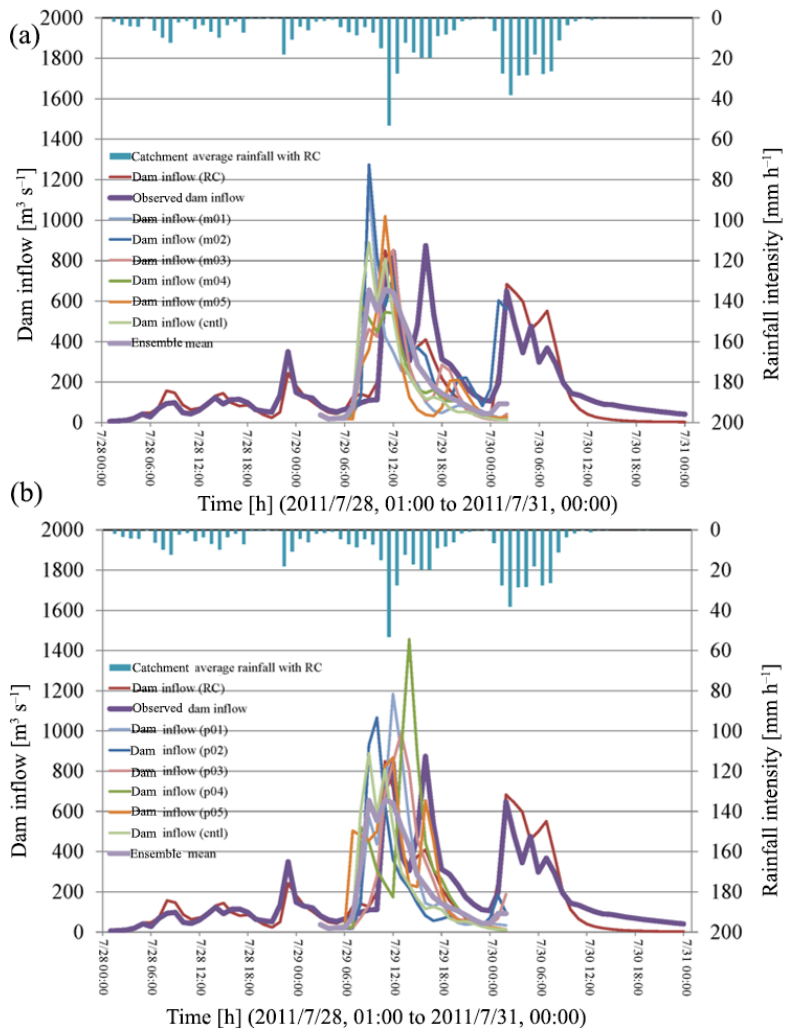
Figure 18. Results of ensemble flood simulations with rainfall position shift (upper: control run and negatively perturbed members; lower: control and positively perturbed